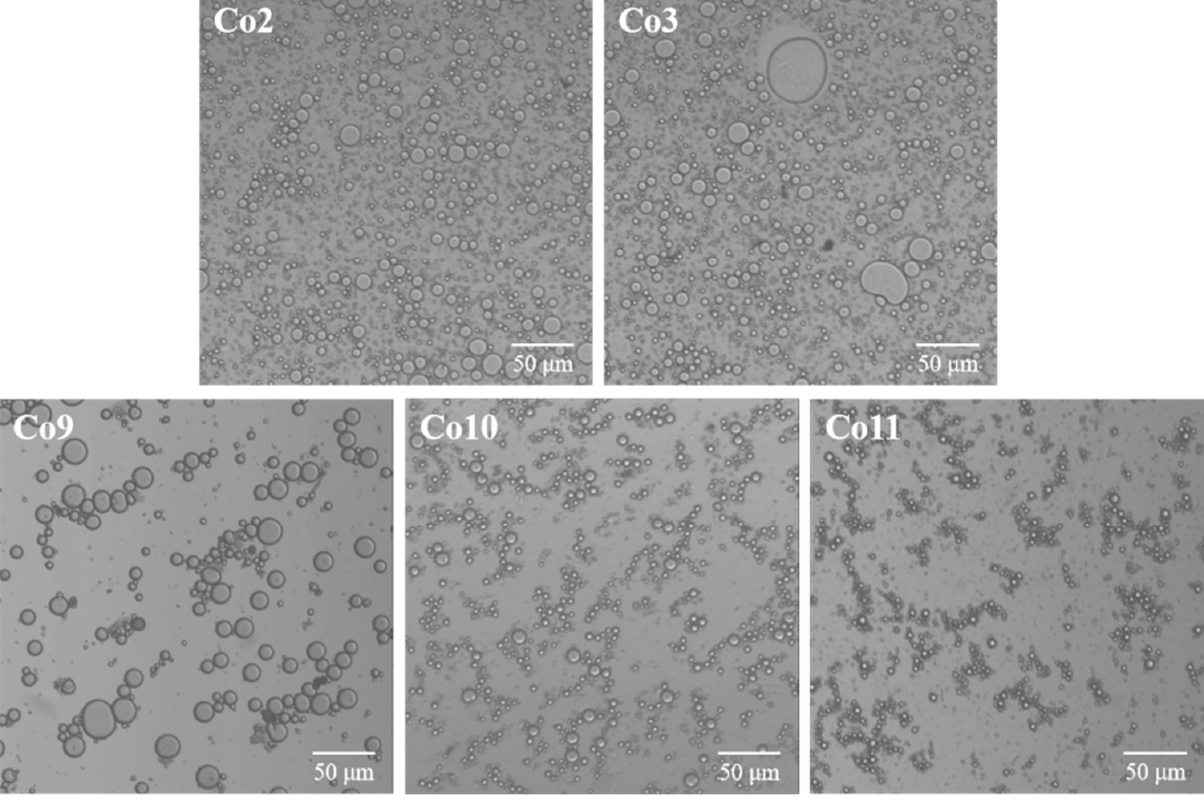
Figure 7. Micromorphology of an emulsion of Co prepared under different extraction pH